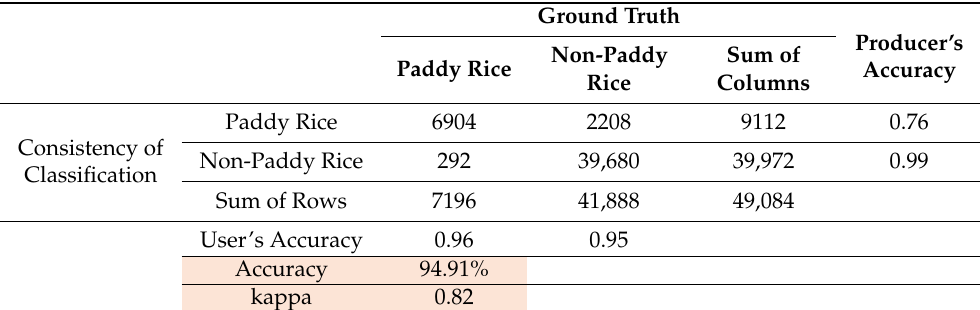
Table 4. Consistency of classification outcome.